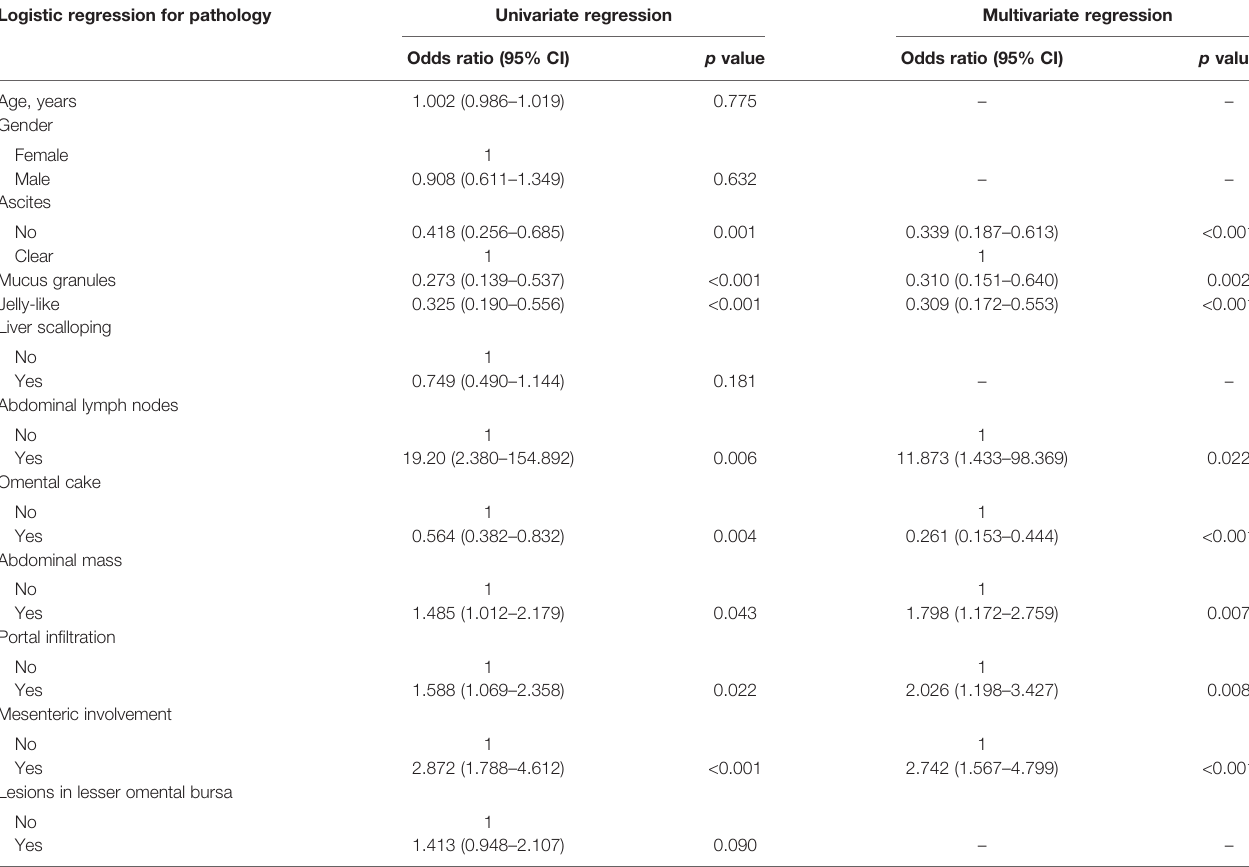
TABLE 3 | The univariate and multivariate logistic regression for pathology.